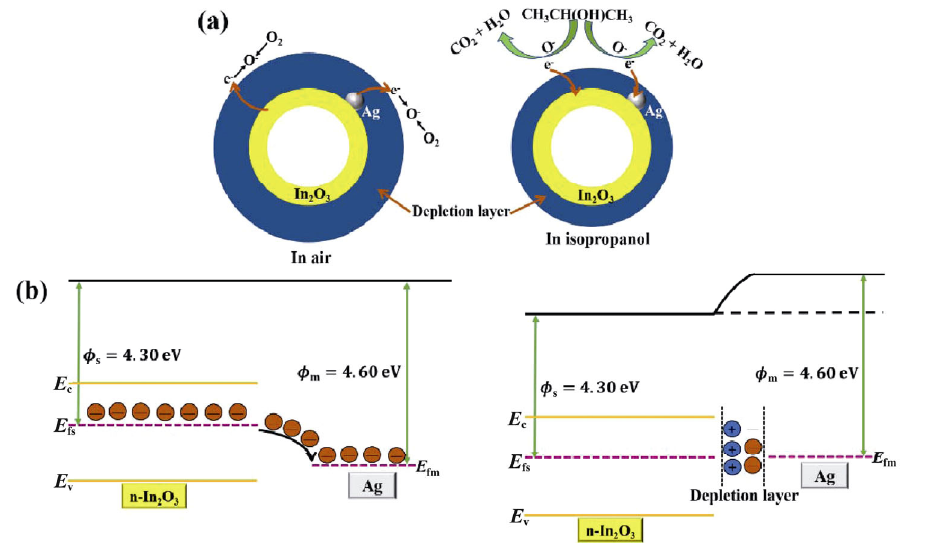
Fig. 14 Schematic of (a) isopropanol sensing mechanism of the Ag–In 2 O 3 and (b) band structure of the Ag–In 2 O 3 composites ( E c , conduction band bottom; E f , Fermi level; E v , valence band